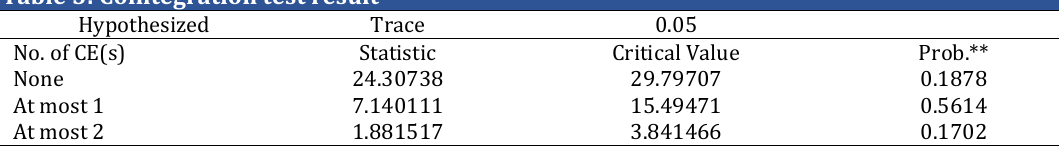
Table 3: Cointegration test